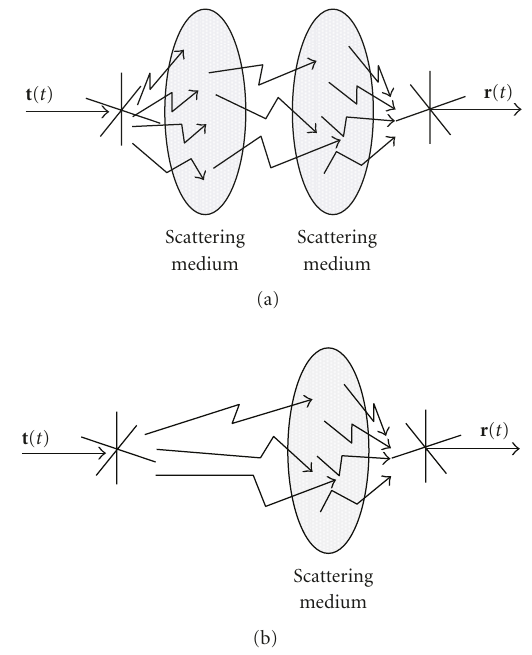
Figure 5: Terrestrial multipath links with compact MIMO anten- nas in scattering media; (a) double-bounce scattering; (b) single bounce.